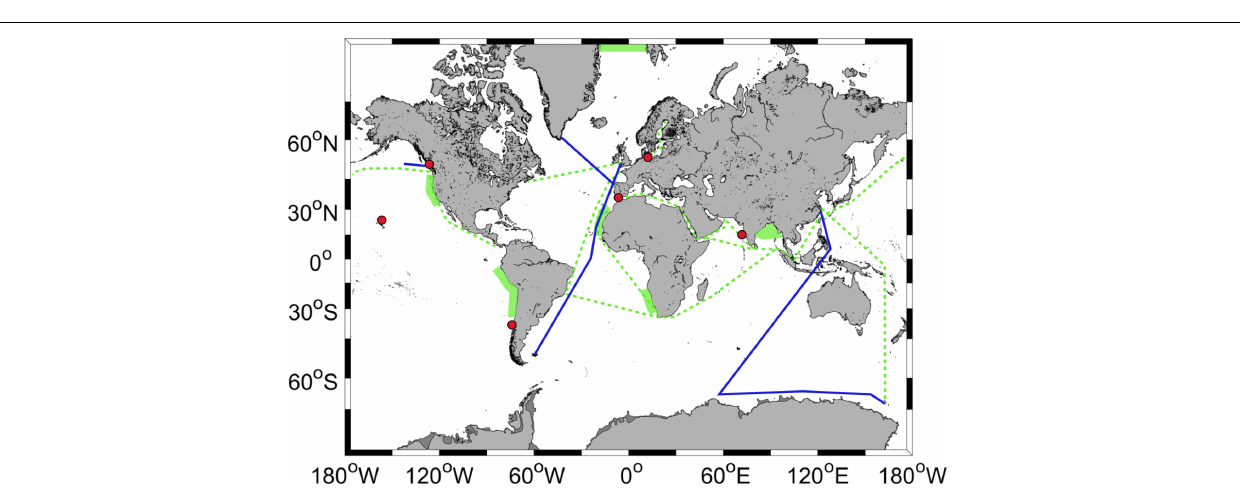
FIGURE 2 | N 2 O baseline measurements proposed for N2O-ON. Blue lines/red points indicate currently active repeated oceanographic sections/fixed time-series stations (see text). Dashed green lines indicate prospective VOS lines to be equipped with systems for continuous measurements. Green shaded areas mark key regions for the establishment of new time-series